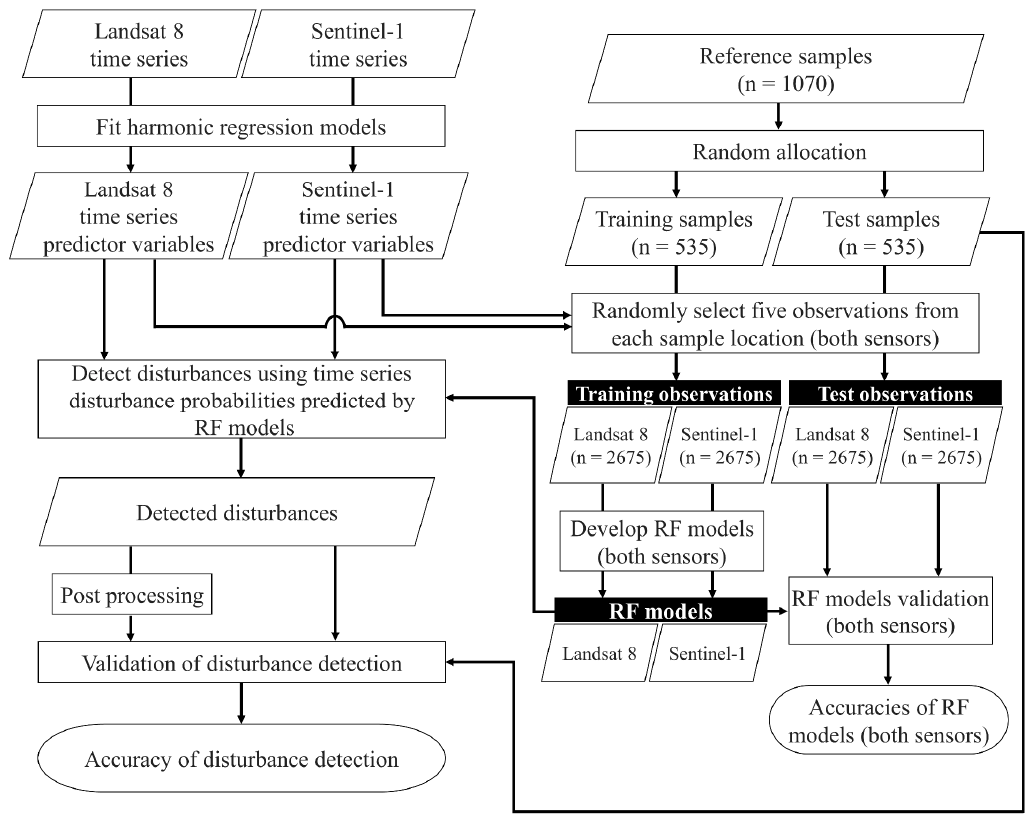
Figure 3. Flowchart of overall analysis. Random Forest (RF) disturbance probability models were developed using the observations of Landsat 8 and Sentinel-1 derived from training samples. Disturbances were detected using disturbance probabilities predicted by the RF models.